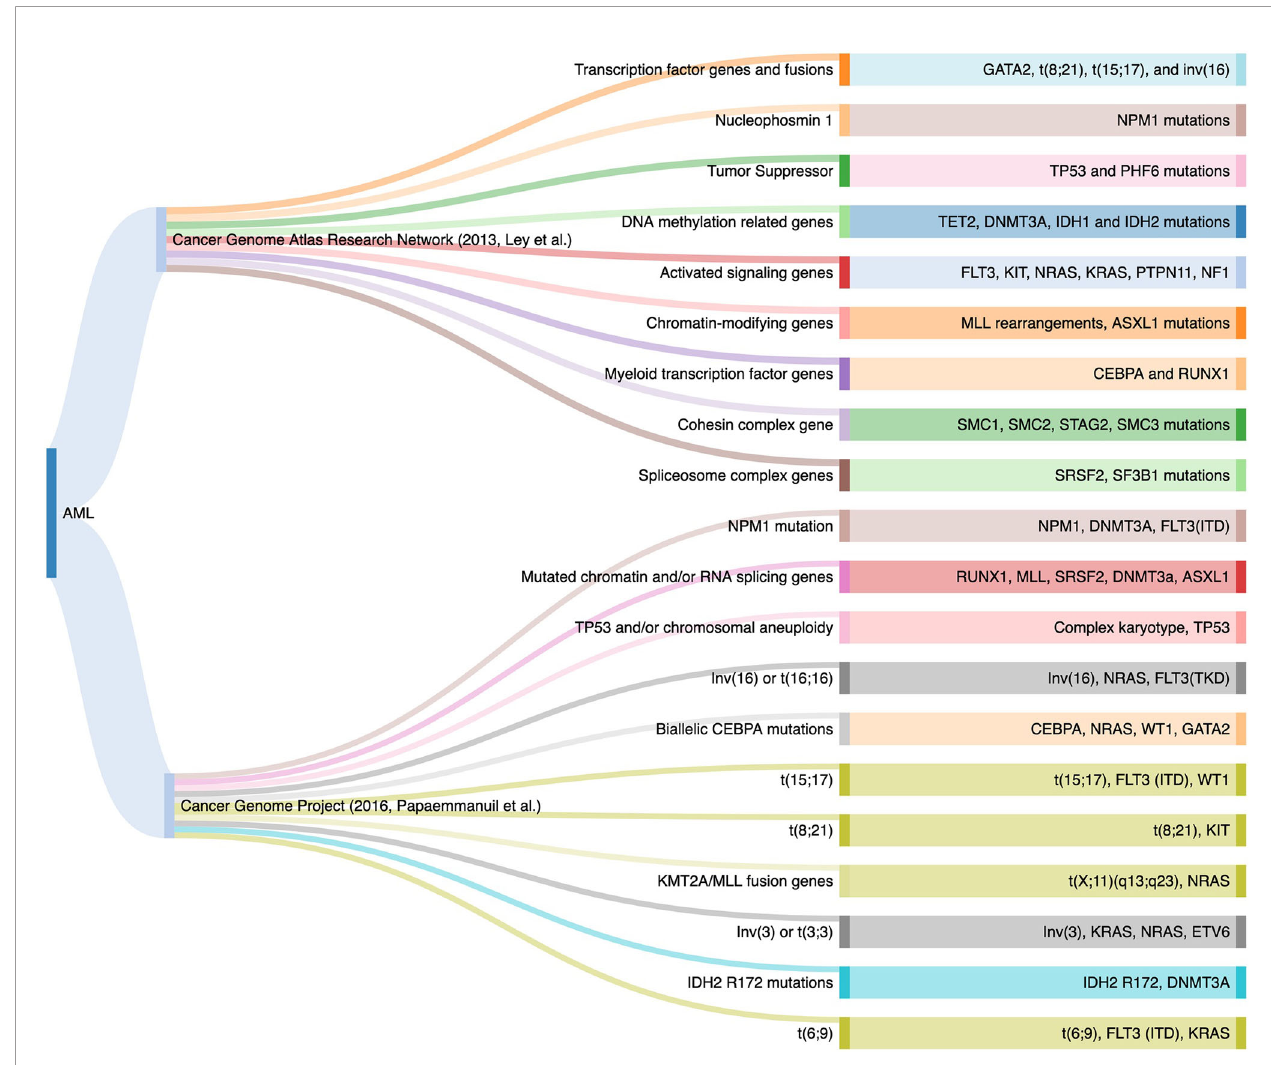
FIGURE 1 | Genomic Classi fi cations of Acute Myeloid Leukemia as Proposed by the TCGA Project and the 2016